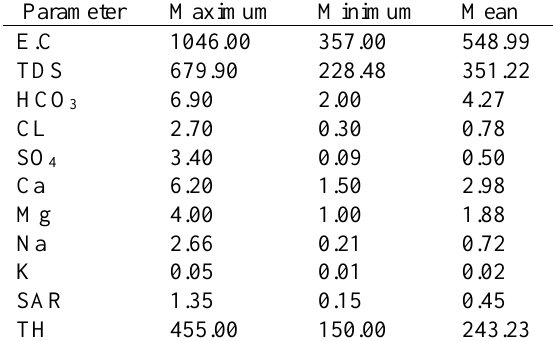
Table 3. Dispersion of used